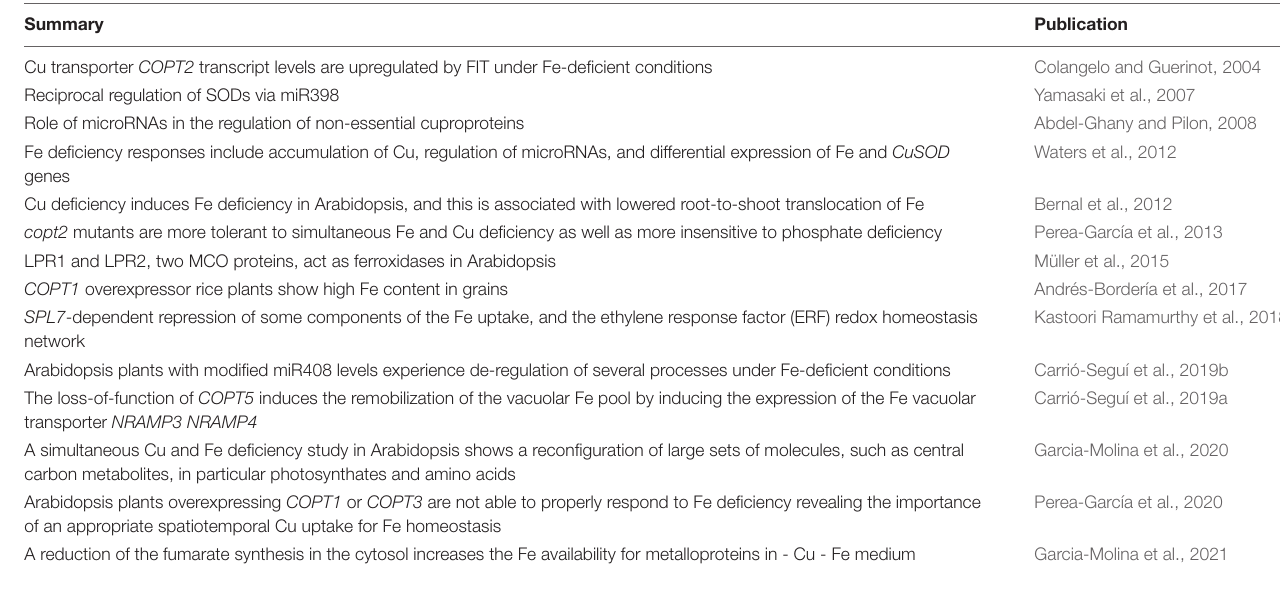
TABLE 1 | Overview of the publications reporting cross-talk between Fe and Cu homeostasis in plants.